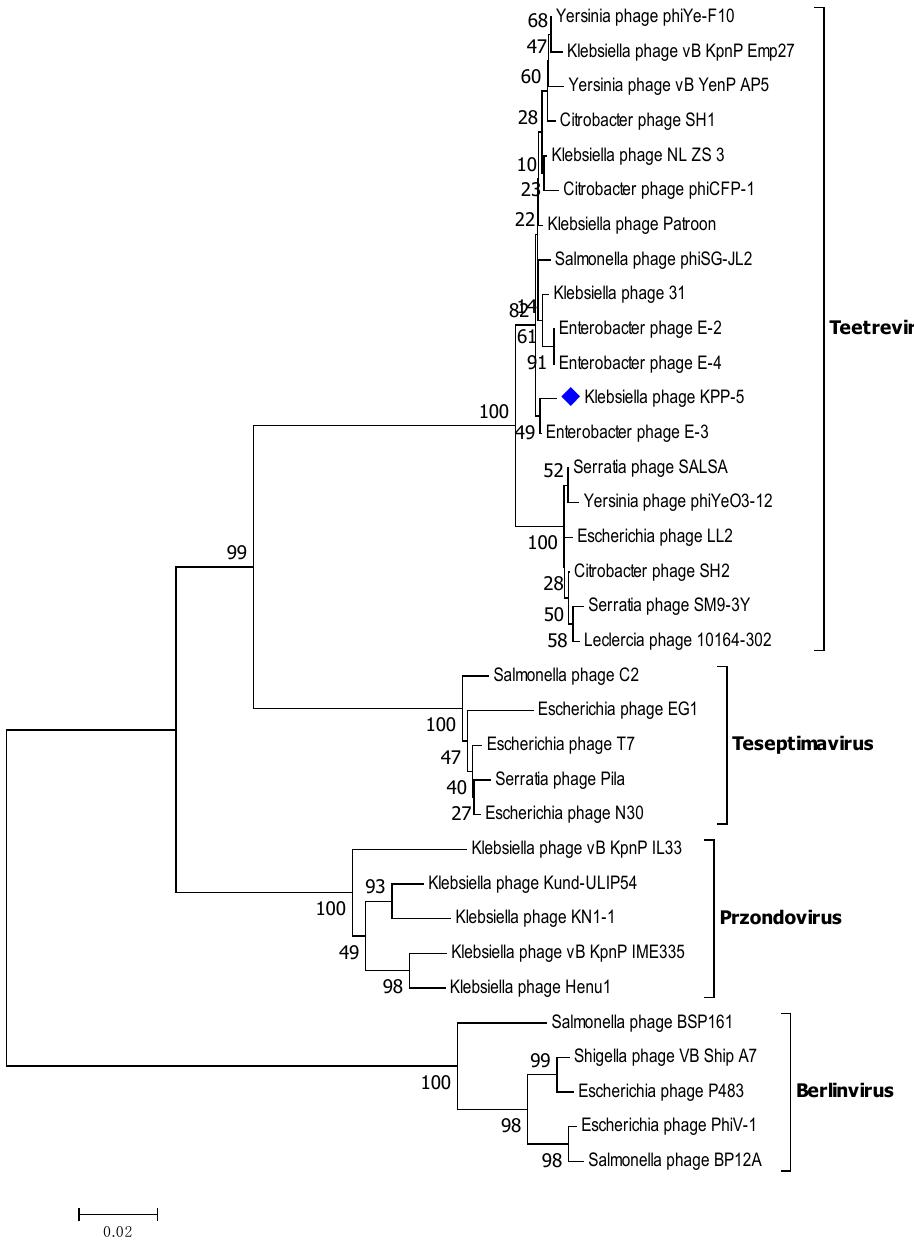
Figure 6. Neighbor-joining tree of Klebsiella phage KPP-5 compared to other phages available in GenBank based on the alignment of DNA polymerase amino acid sequences. The numbers represent bootstrap percentage values based on 1000 replicates.